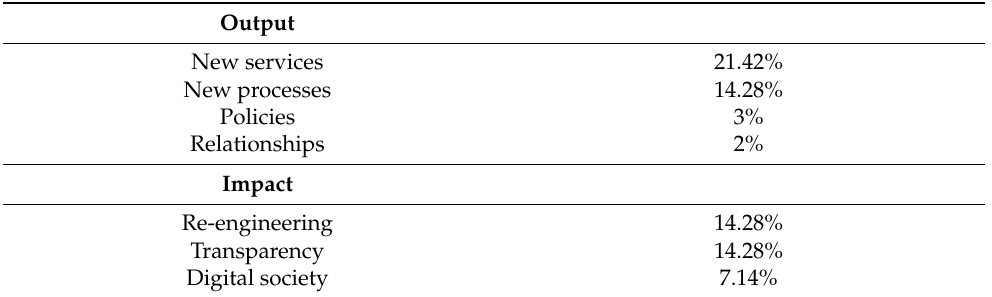
Table 4. Results of digital